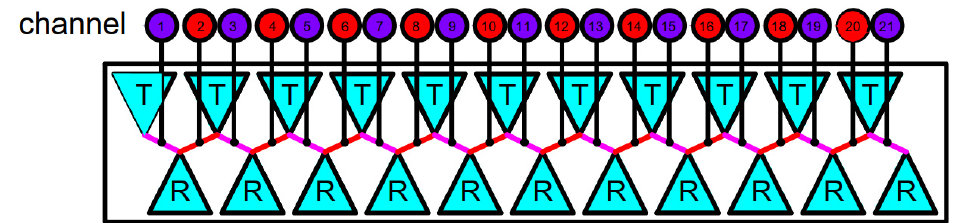
Figure 5. Internal vibrator arrangement of air ‐ coupled antenna of three ‐ dimensional ground ‐ pene ‐ trating radar.